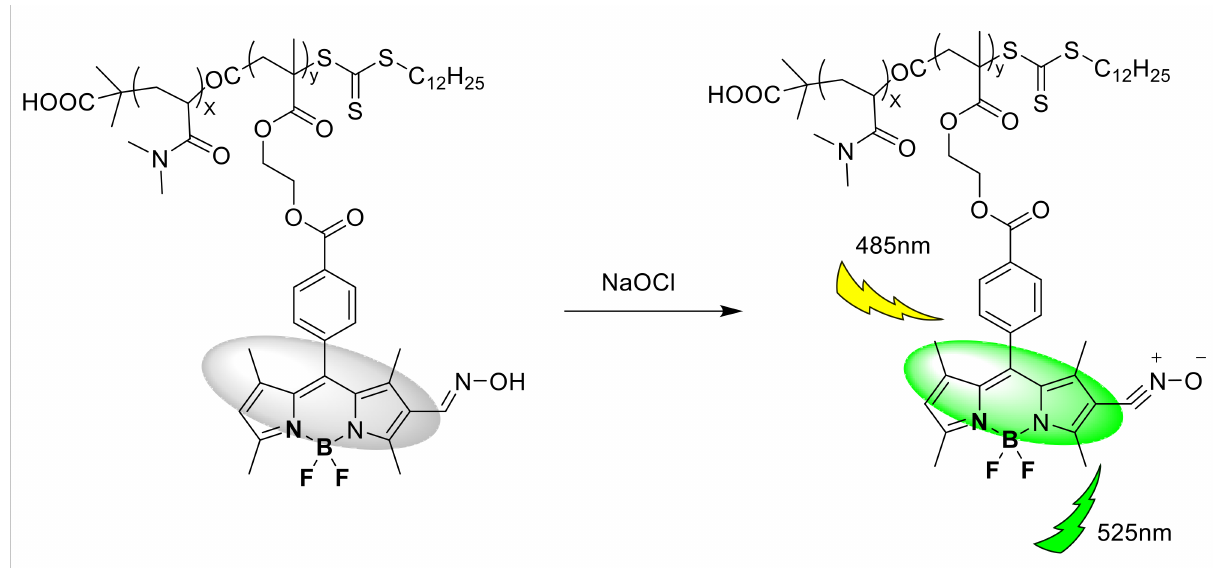
Figure 10. The reaction of probe 9 and ClO −